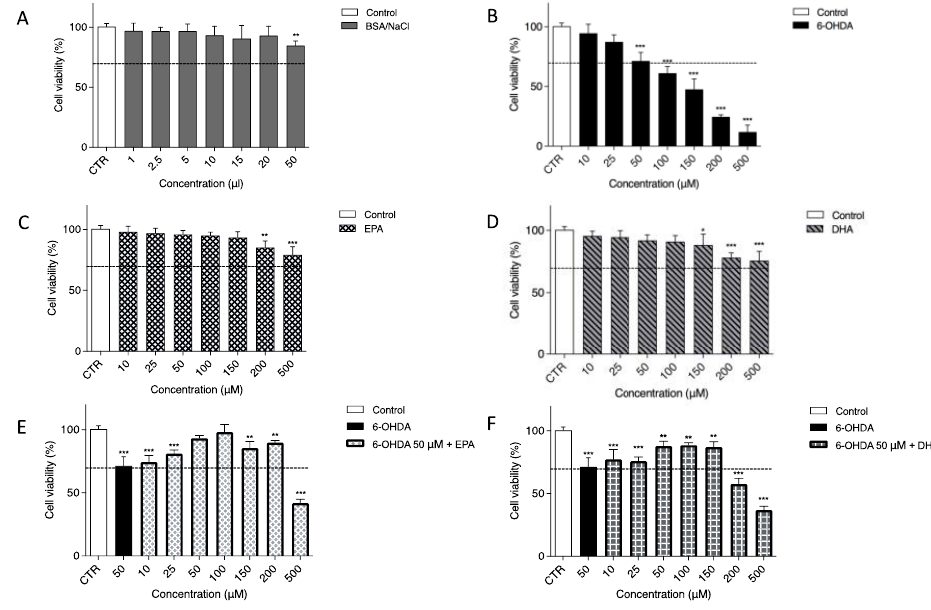
Figure 1. Effect of 6-OHDA, EPA, and DHA (alone or in combination) on the viability of SH-SY5Y cell line. Cells were treated for 24 h using BSA/NaCl solution as vehicle treatment condition ( A ) and different concentrations of 6-OHDA ( B ), EPA ( C ), or DHA ( D ). Based on this result, 50 µ M 6-OHDA was used to treat the cells together with EPA ( E ) or DHA ( F ). In the last two cases, the first column represents untreated cells (white), the second column is the viability after 50 µ M 6-OHDA treatment (black) and all other columns show co-treatment with 50 µ M 6-OHDA and two omega-3 fatty acids. Cell viability was assessed using MTT assay. Data from three independent experiments using four independent cultures per condition were analyzed by ANOVA using Graphpad Prism software. * * p < 0.01, ** p < 0.001, and *** p <